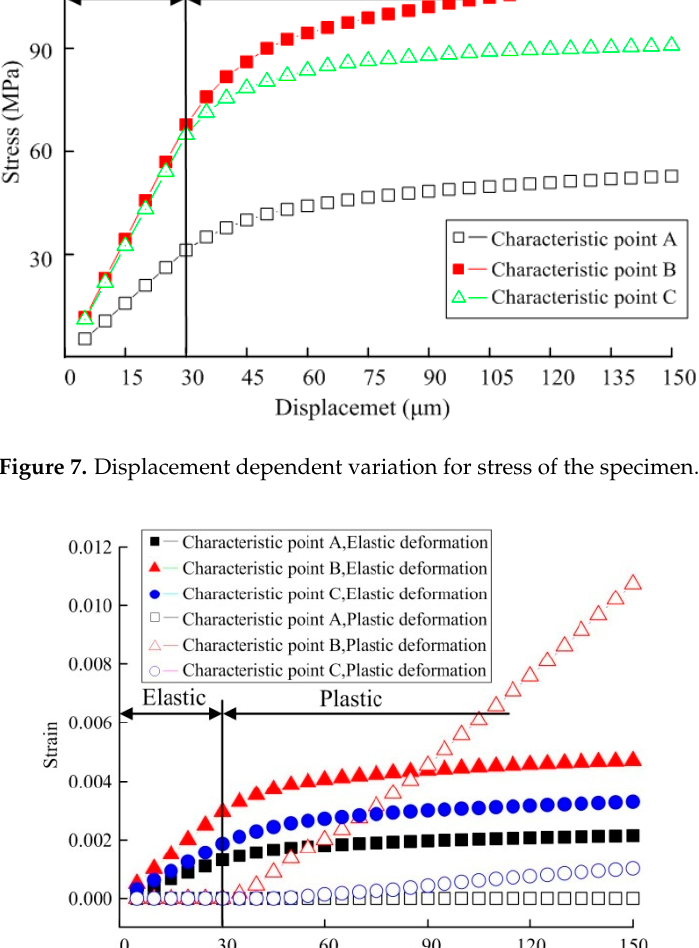
Figure 8. Displacement-dependent variation for strain of the specimen under biaxial tensile load.